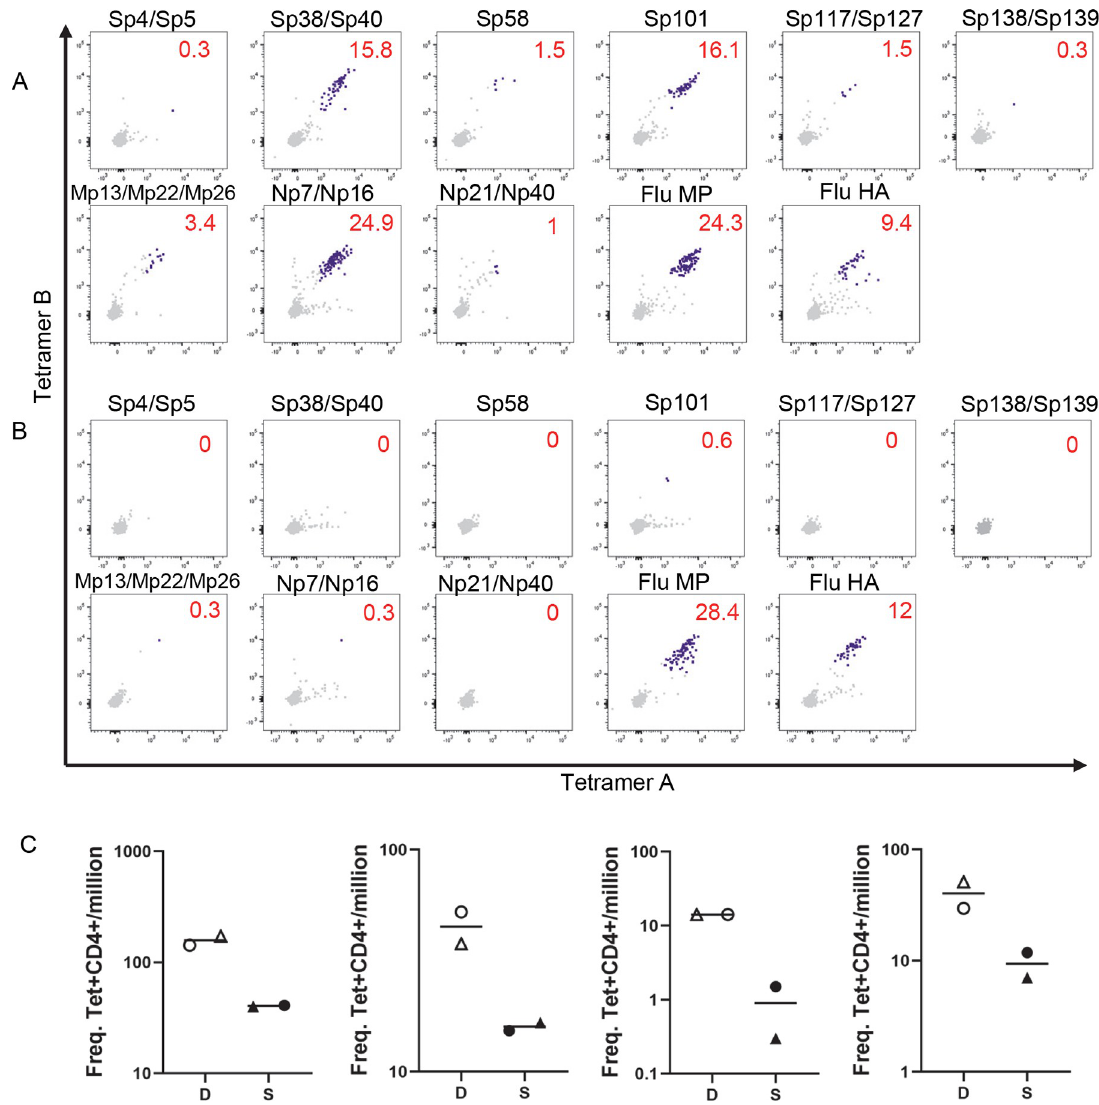
Fig 1. Analysis of SARS-CoV-2-reactive CD4+ T cells by direct ex vivo staining of PBMC with class II tetramer reagents. (A-B) PBMCs were incubated with two rounds of a panel of combinatorial peptide-specific tetramers and tetramer positive cells were enriched through a magnetic column before analysis. Sp4 (S 25-44 ), Sp5 (S 33-52 ), Sp38 (S 297-316 ), Sp39 (S 305-324 ), Sp58 (S 457-476 ), Sp101 (S 801-820 ), Sp117 (S 929-948 ), Sp127 (S 1009-1028 ), Sp138 (S 1097-1116 ), Sp139 S 1105-1124 ), Mp13 (M 97-116 ), Mp22 (M 169-188 ), Mp26 (M 201-220 ), Np7 (N 49-68 ), Np16 (N 121-140 ), Np21 (N 161-180 ), Np40 (N 313-332 ), Flu MP (Flu MP 61-75 and MP 97-116 ), Flu HA (Flu HA 269-283 and HA 306-318 ). Tetramers A and B are tetramers with identical epitope as indicated in each panel, but with different fluorochromes. (A) Representative example of DR0401 SARS-CoV-2 exposed individual. Numbers indicate the frequency of tetramer-positive cells per million CD4+ T cells. (B) Representative example of DR0401 SARS-CoV-2 unexposed individual. Numbers indicate the frequency of tetramer-positive cells per million CD4+ T cells. (C) Frequency of T cells specific for dominant (D) and subdominant (S) epitopes for DR0401 SARS-CoV-2 exposed individuals. Each graph represents an exposed individual. Sp38/Sp40 (open circle), Sp101 (open triangle), Sp117/Sp127 (closed circle), and Sp138/Sp139 (closed